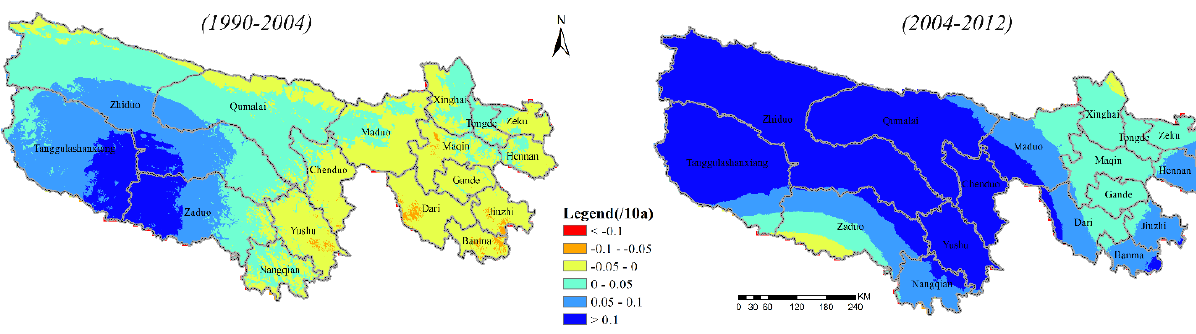
Figure 10. Spatial distribution of annual HI change rate in the TRH